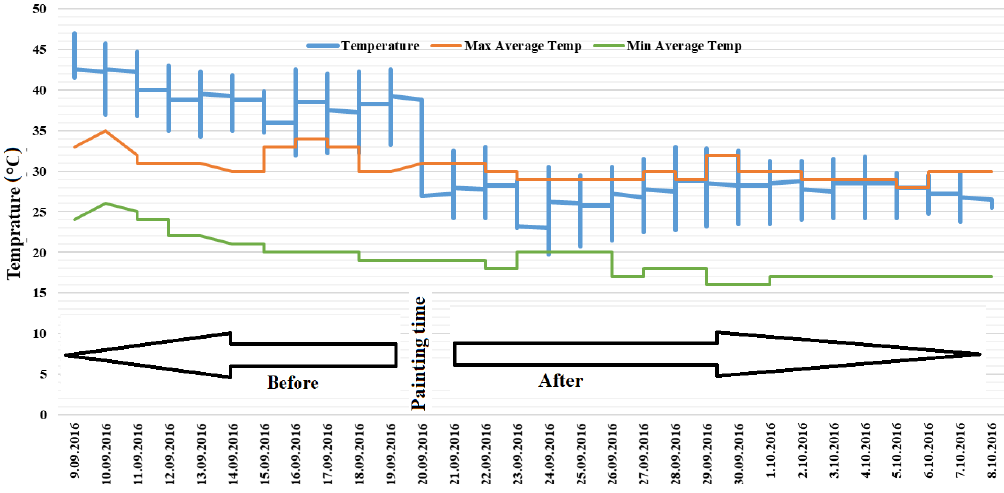
Figure 12. Measurement values of daily average and maximum/minimum temperatures for TR6.